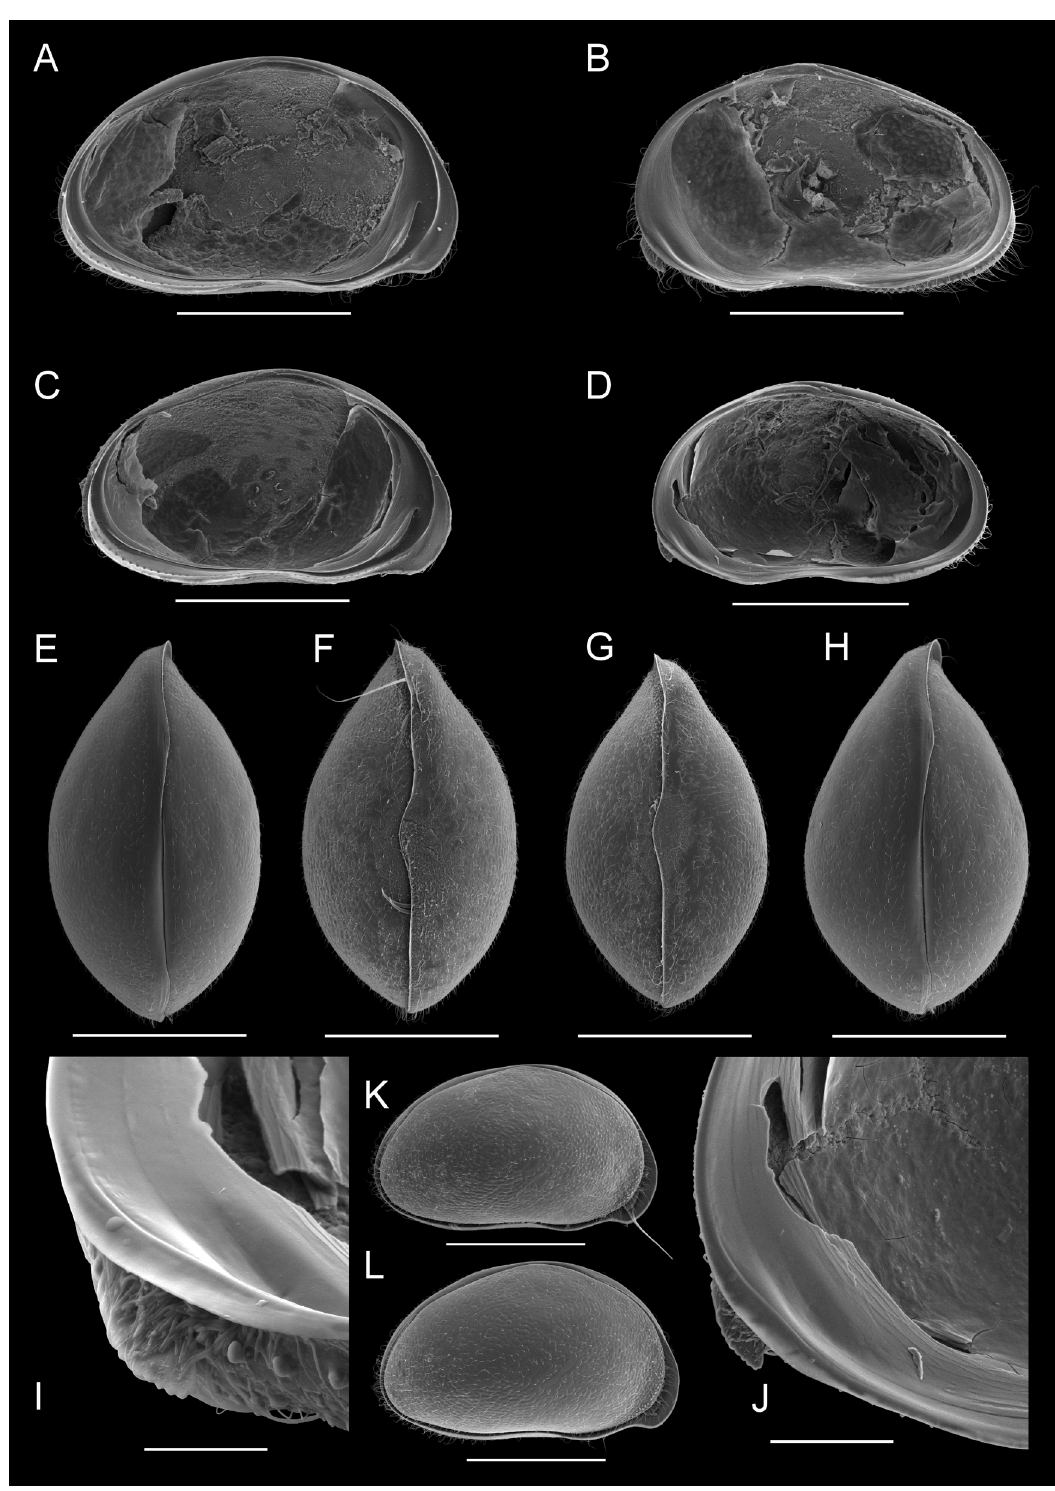
Fig. 4. Bennelongia dedeckkeri sp. nov., all from Lake Galilee, QLD (Type locality). A . ♀, LVi (W40020). B . ♀, RVi (W40019). C . ♂, LVi (W40016). D . Holotype ♂, RVi (W40075). E . ♀, Cp dorsal (W40025). F . ♀, Cp ventral (W40026). G . ♂, Cp (ventral W40023). H . ♂, Cp dorsal (W40022). I . Holotype ♂, RVi detail anteriorly (W40075). J . ♂, RVi detail anteriorly (W40019). K . ♂, CpRl (W40021). L . ♀, CpRl (W40024). Scales: A-H, K-L = 500 μm, I-J = 100